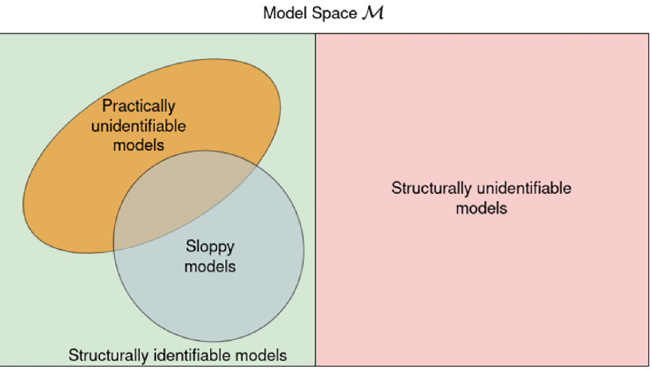
Fig 2. The relationship between structural identifiability, practical identifiability, and